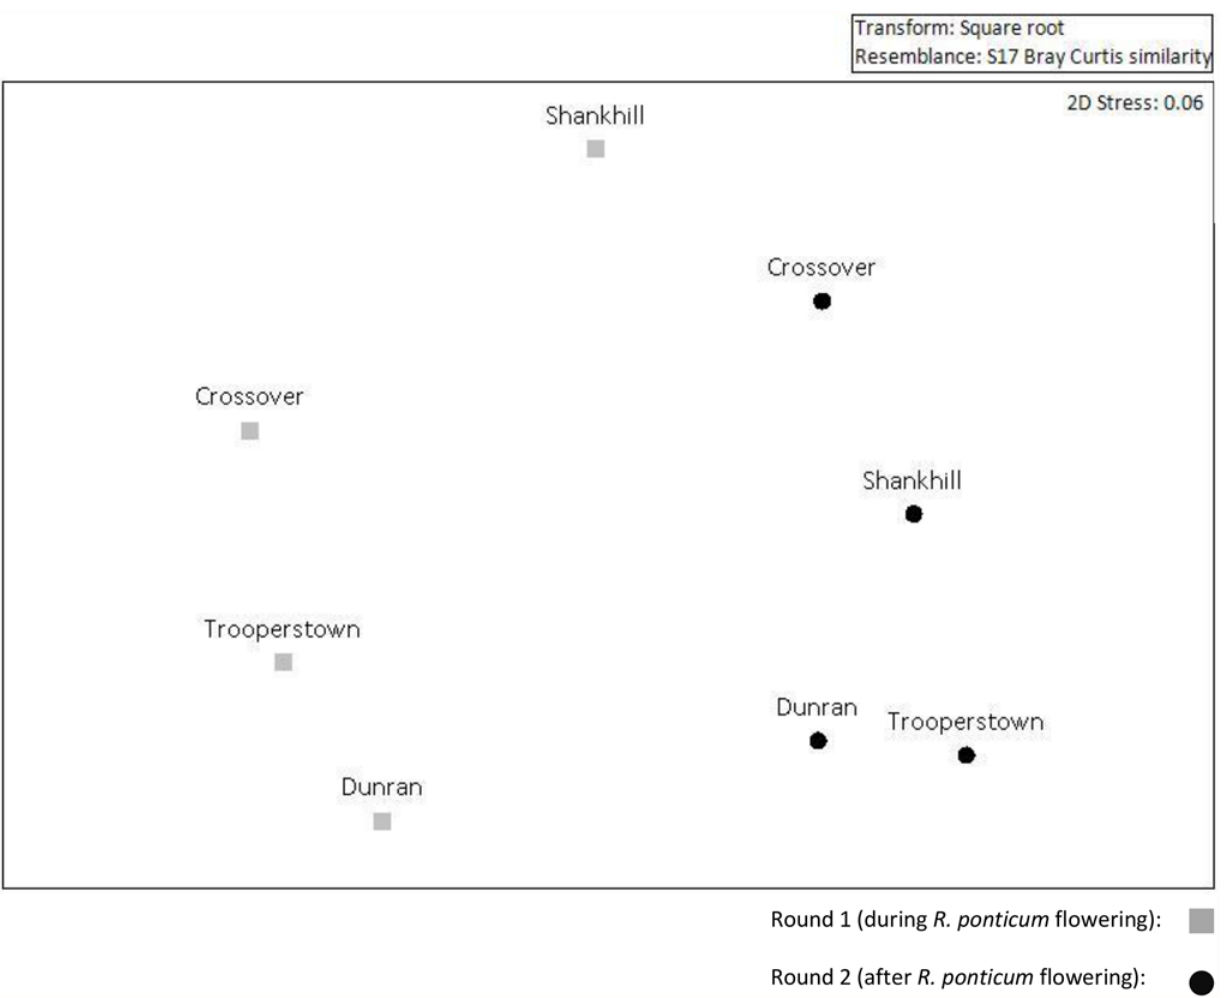
Fig 4. Non-metric Multi-Dimensional Scaling plot of flower-visitor interaction frequencies Flower-visitor composition at sites invaded by R . ponticum during (round 1) and after (round 2) flowering. Site level mean interaction frequencies of pollinator groups were used to calculate the resemblance matrix. The closer the points, the more similar the identity and abundance of interaction frequencies of flower-visitors recorded. Data were square root transformed to balance contributions of rarer and dominant insect